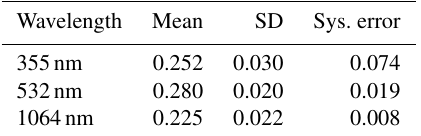
Table 2. SALTRACE mean particle linear depolarization ratio and corresponding standard deviation (SD), for all three wavelengths, observed within the Saharan dust layer with BERTHA in June and July 2013 and June and July 2014 (21 cases). Typical uncertain- ties in the retrieval of individual particle depolarization-ratio values (systematic errors, Sys. error) are given for comparison. These un- certainties consider the volume depolarization retrieval uncertain- ties (see Appendix) and uncertainties in the backscatter coefficients required as input in addition. Sys.